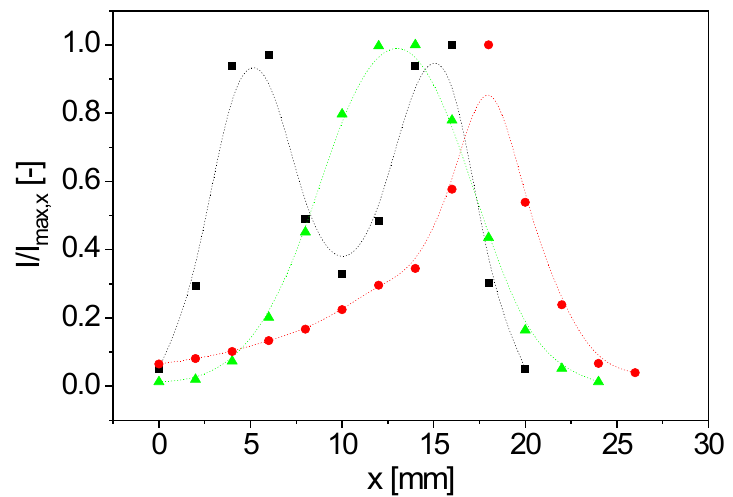
Figure 5. Measured normalized signal intensity profiles along x with a small water sample for the three different coil geometries ( ■ : figure-8 coil, ν L = 22.18 MHz; ●: spirally wound, bent surface coil, ν L = 21.99 MHz; : solenoidal coil, ν L = 22.0 MHz). The sample was moved in 2 mm incremental steps along x (coordinate system of Figure 1). Pulse duration and frequency were kept constant for each coil. The geometries exhibit different intensity profiles along x . The solenoidal coils and the spirally wound, bent surface coils show a single intensity maximum, while two maxima were measured for the bent figure-8 coil, with approximately the same normalized signal intensity.